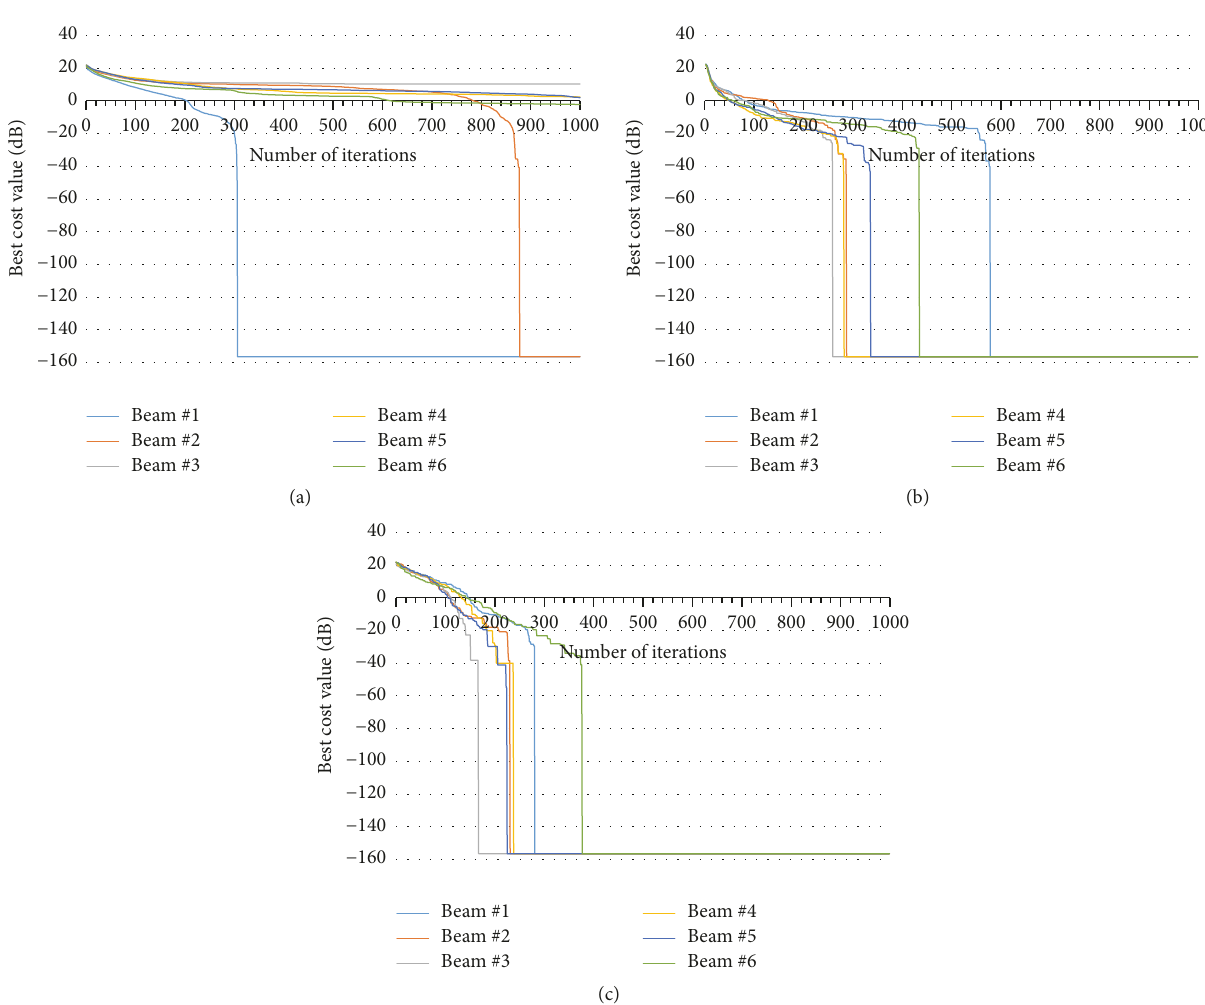
Figure 11: Comparison results of the convergence process. (a) GA. (b) Conventional PSO. (c) QPSO.